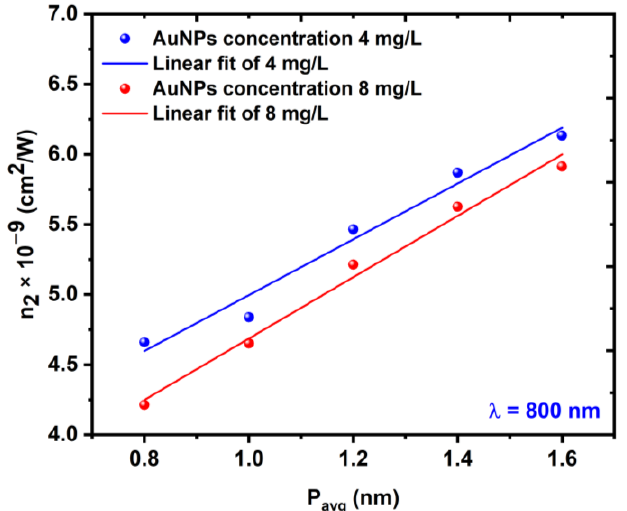
Figure 12. The CA z-scan measurements of the Au NP sample with a concentration of 8 mg/L for different excitation wavelengths that ranged from 740 to 820 nm ( a – e ) at a constant average power of 1.4 W nm.